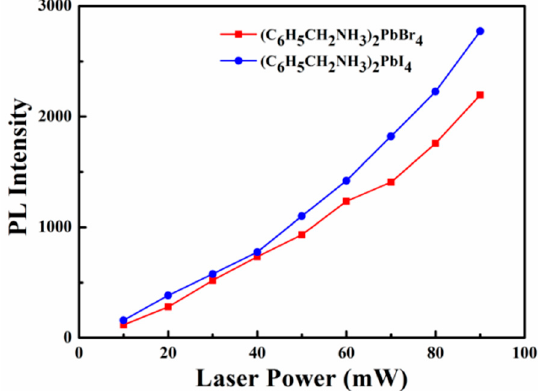
Figure 8. Laser power dependence of the photoluminescence (PL) intensity of the perovskites (C 6 H 5 CH 2 NH 3 ) 2 PbBr 4 (red curve) and (C 6 H 5 CH 2 NH 3 ) 2 PbI 4 (blue curve).